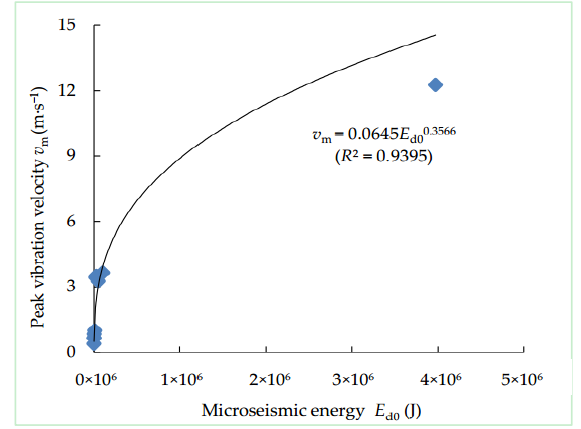
Figure 2. Fitting relationship between peak vibration velocity v m and microseismic energy E d0 , presenting a power function relation.